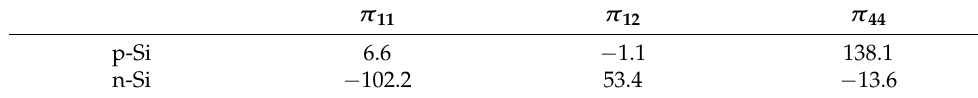
Table 1. Piezoresistive coefficient of monocrystalline silicon (10 − 11 /Pa).